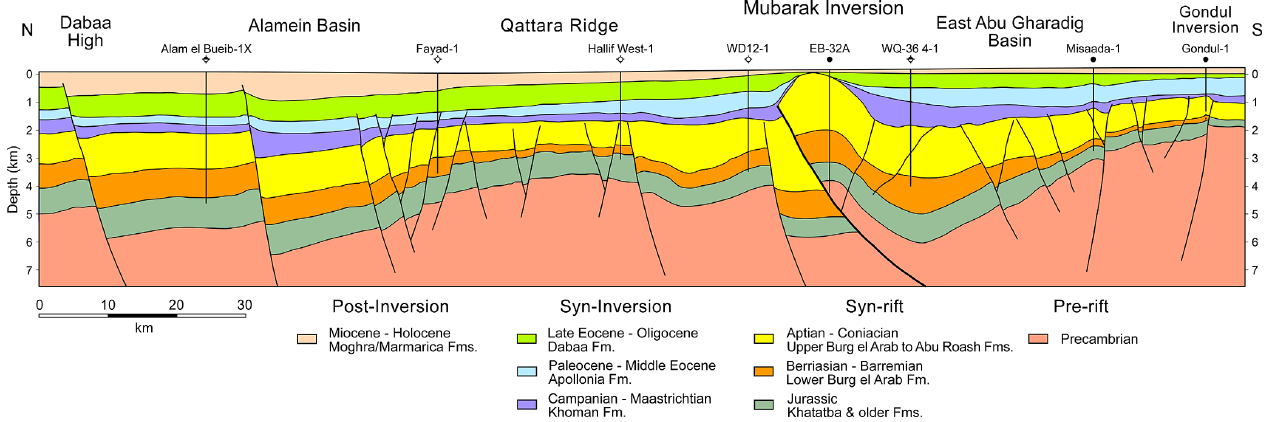
Figure 7. Regional geoseismic section across the eastern part of the Western Desert. Location is shown in Fig. 2. The massive Mubarak inversion is one of the best examples of Western Desert Santonian inversion followed by younger pulses of shortening. After Bosworth et al. (2008). Four times vertical